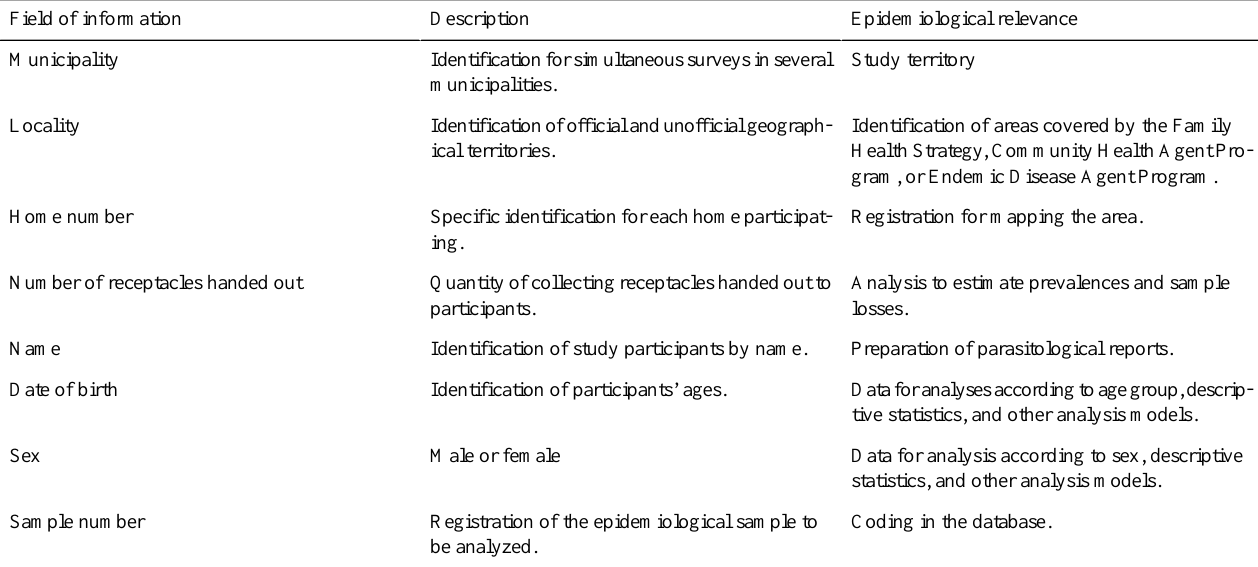
Table 2. Variables to be gathered for registering homes and individuals participating in the